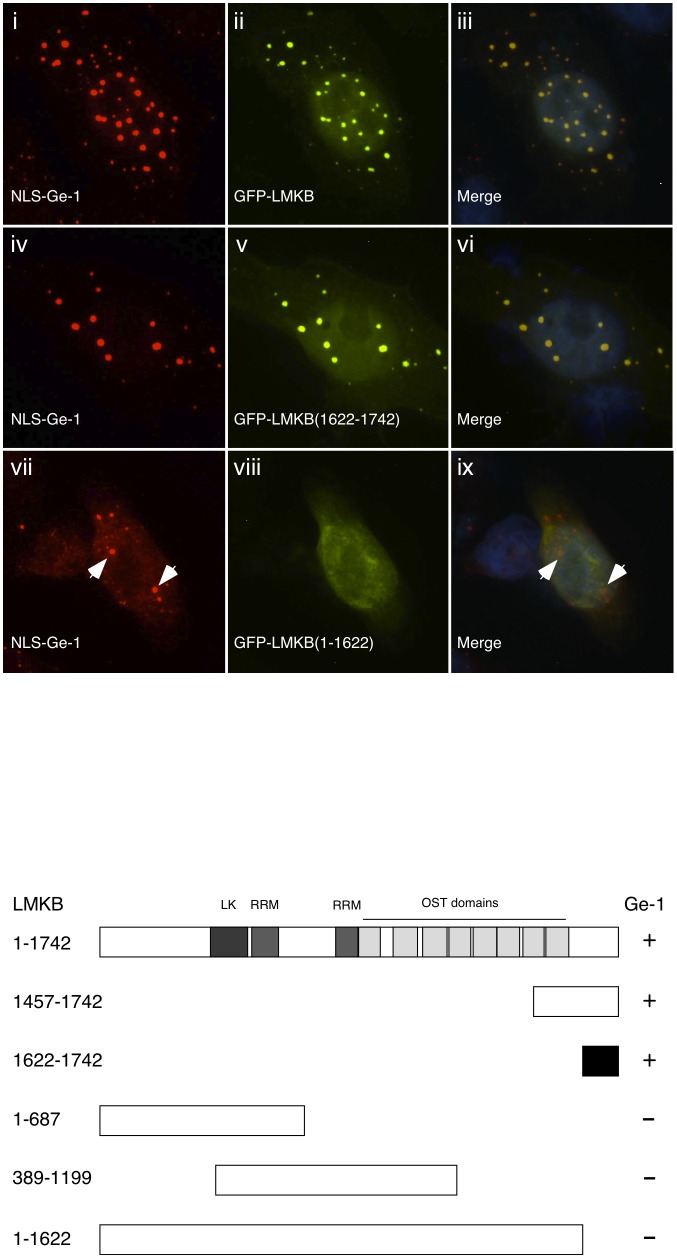
A. A modified two-hybrid assay was used to test for interaction between LMKB and Ge-1 and to identify the portion of LMKB that mediates interaction with Ge-1.Expression of a plasmid encoding Ge-1 fused to a nuclear localization sequence (NLS) shifted some of the protein from the cytoplasm to the nucleus of HEp-2 cells (red, i, iv and vii), where it localized to dot-like structures. Co-transfection of plasmids encoding GFP fused to full-length LMKB (green, ii) and NLS-Ge-1 resulted in co-localization of the two proteins in nuclear dots. GFP-LMKB fragment fusion proteins encoding amino acids 1622–1742 (green, v) also co-localized with co-expressed NLS-Ge-1 (red, iv) in nuclear dots. GFP-LMKB fragments encoding 1–687 and 389–1199 (both not shown) and 1–1622 (green, viii) did not co-localize with NLS-Ge-1 in nuclear dots. Merge of fluorescence in i and ii, iv and v, vii and viii is shown in iii, vi and ix. DAPI staining (blue) in iii, vi and ix indicates the location of nuclei. Human serum 0121 containing anti-Ge-1 antibodies and mouse monoclonal anti-GFP antibodies were used to detect Ge-1 and GFP, respectively. White arrows in vii and ix indicate nuclear dots containing NLS-Ge-1. White bar in ix indicates 5.0 µm. B. Schematic representation of the structure of LMKB and summary of results. LMKB contains an N-terminal globular domain (“LK”, amino acids 351–493) that may serve as a cation binding domain. Two RRM-type RNA binding domains are located between amino acids 510–600 and 792–867. The C-terminus of LMKB contains eight helix-turn-helix folds (“OST domains”) that are predicted to bind to dsRNA (amino acids 879–937, 1004–1074, 1100–1170, 1176–1247, 1259–1330, 1337–1406, 1412–1484, 1487–1557; numbering system is as indicated in GenBank #NM_014647). + indicates an interaction between a LMKB fragment and Ge-1; - indicates a fragment of LMKB that does not interact with Ge-1. The black rectangle indicates the smallest tested portion of LMKB that interacts with Ge-1.